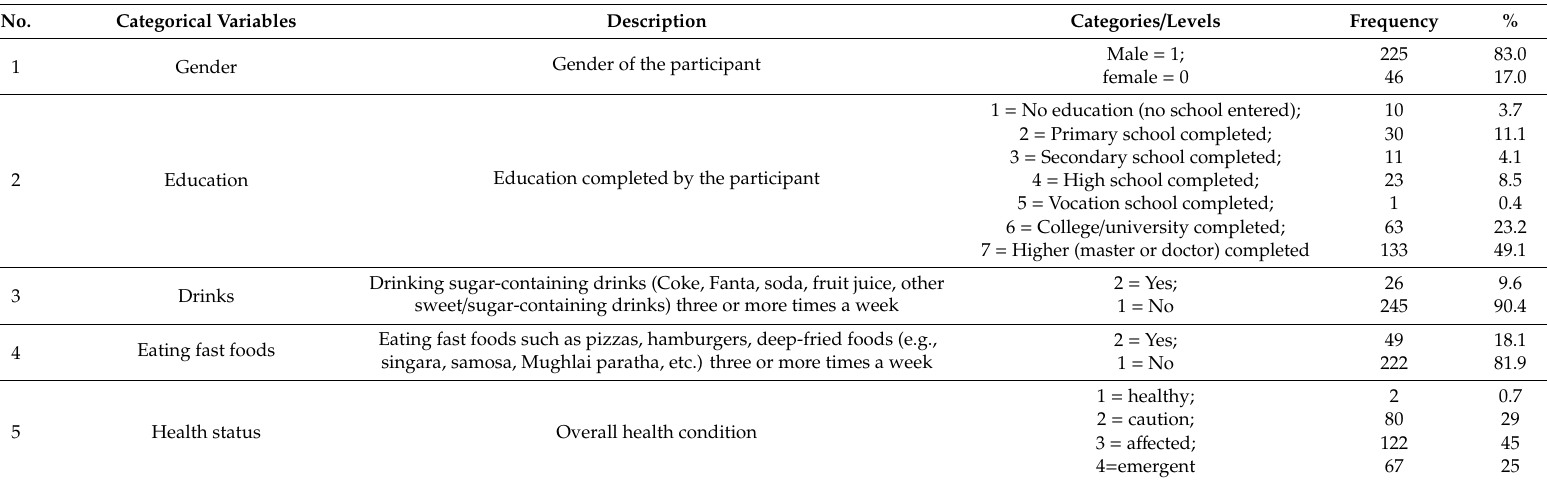
Table 4. Summary statistics of the selected categorical